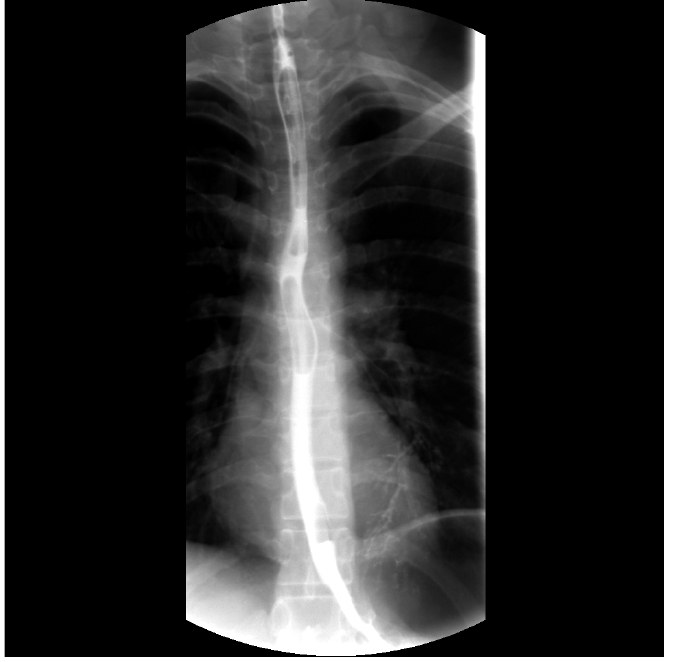
Figure 3. Normal